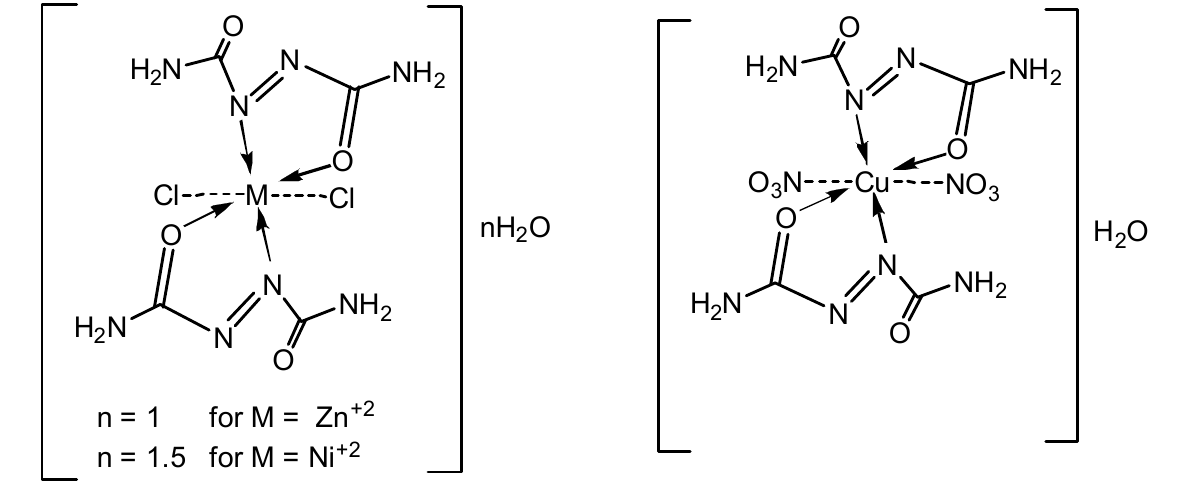
Figure 2. The proposed structures of the synthesized complexes. Table 1. Micro analytical and physical data for azodicarbonamide and its